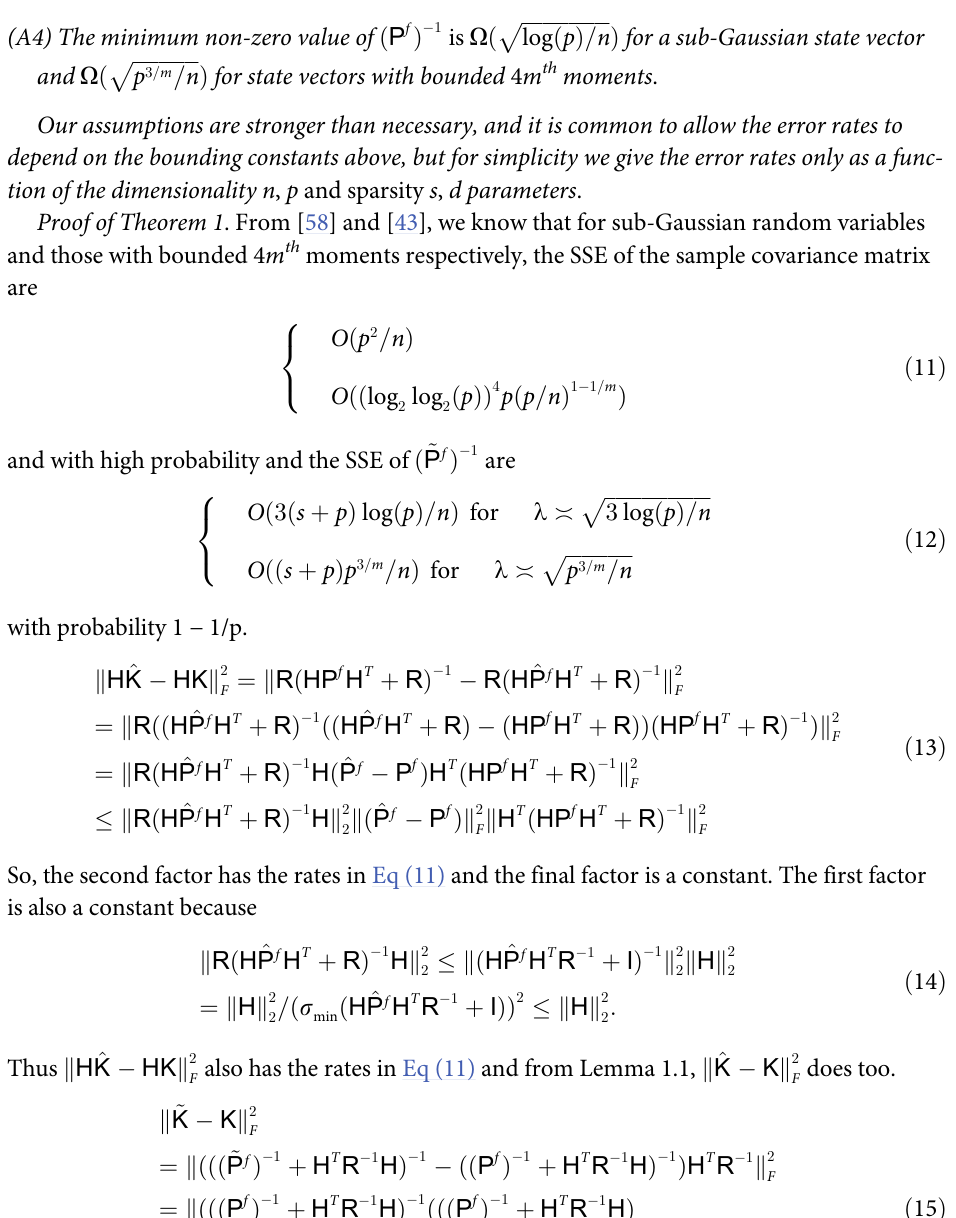
ffiffiffiffiffiffiffiffiffiffiffiffiffiffiffiffiffi p Þ for a sub-Gaussian state vector log ð p Þ = n